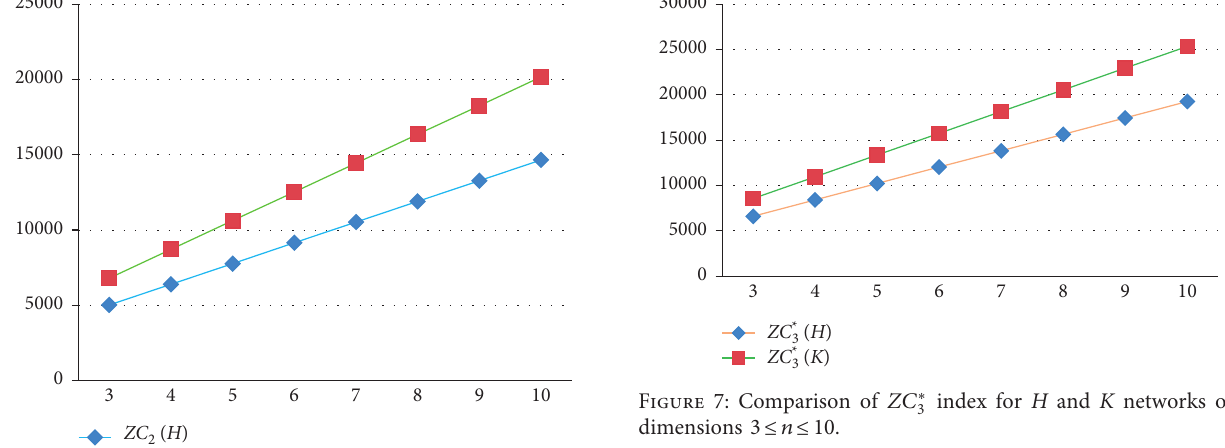
index for H and K networks on 3